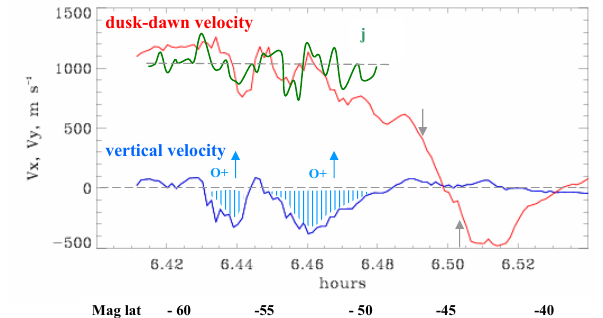
Fig. 5. Two components of the ion plasma velocity observed at 730km by ADV when Demeter crosses the auroral oval. Red and blue stand for the horizontal and vertical velocities, respectively, measured in the plane perpendicular to the satellite orbital mo- tion. Velocities are positive/negative when plasma moves toward dawn/dusk and